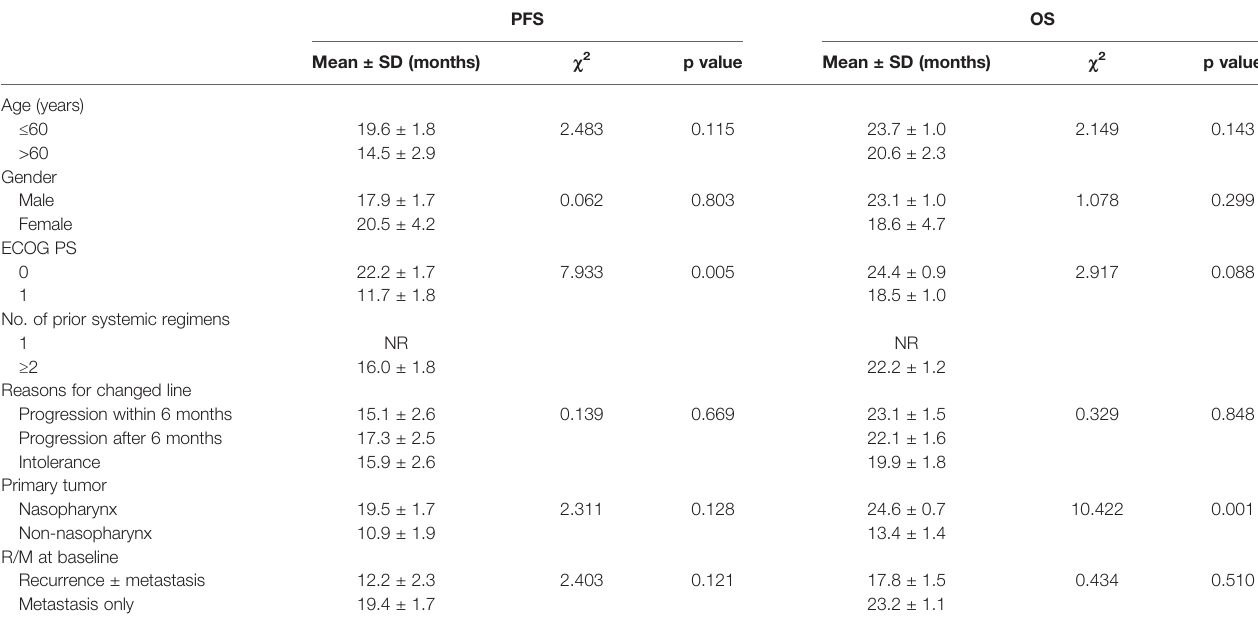
TABLE 4 | Univariate analysis of factors associated with PFS and